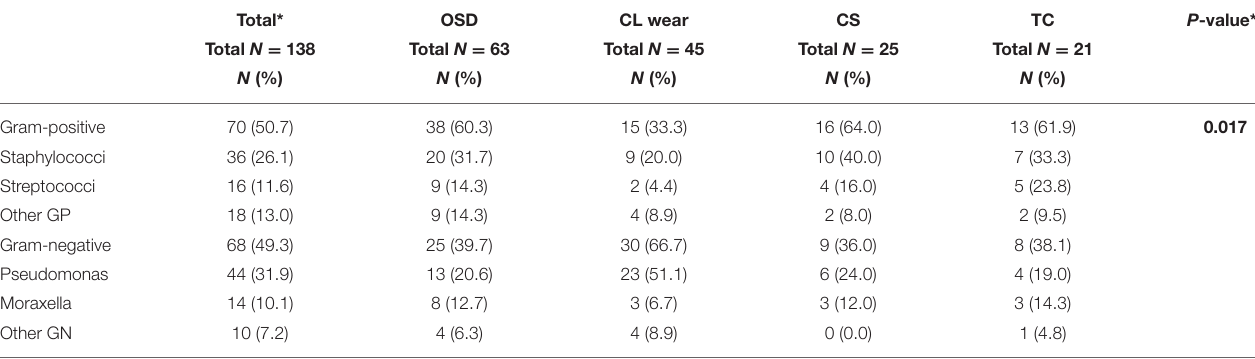
TABLE 3 | Summary of causative organisms of bacterial keratitis in Nottingham, UK, and their association with different risk factors.